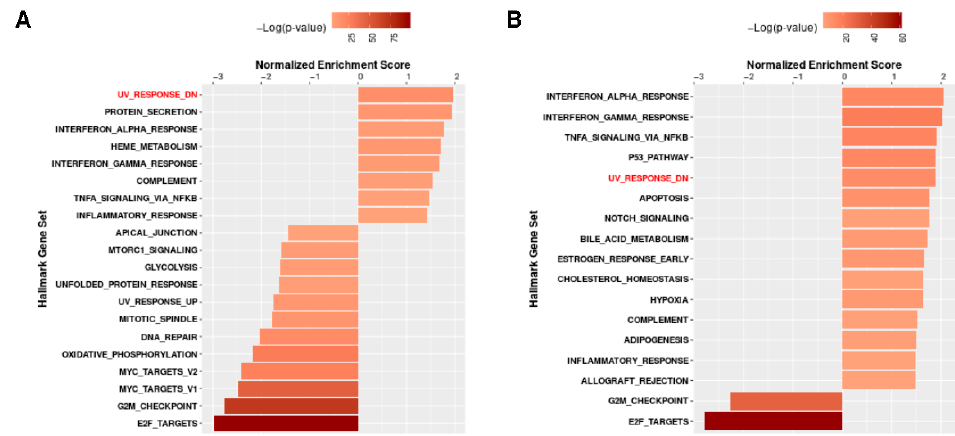
Figure 10. NicheNet analyses of progeria and aging. ( A ) GSEA pathways when comparing nonagenarians and healthy children. ( B ) GSEA pathways when comparing HGPS patients and healthy children.